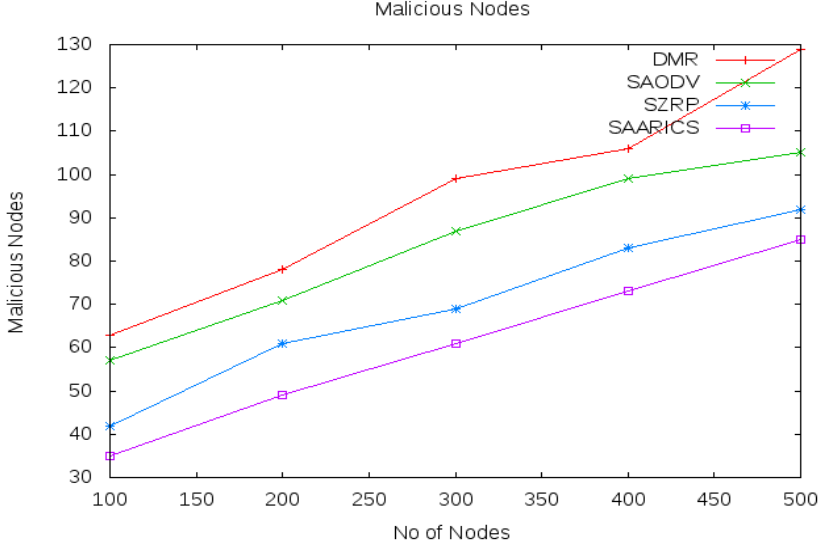
Figure 8. Ratio of Malicious Nodes.